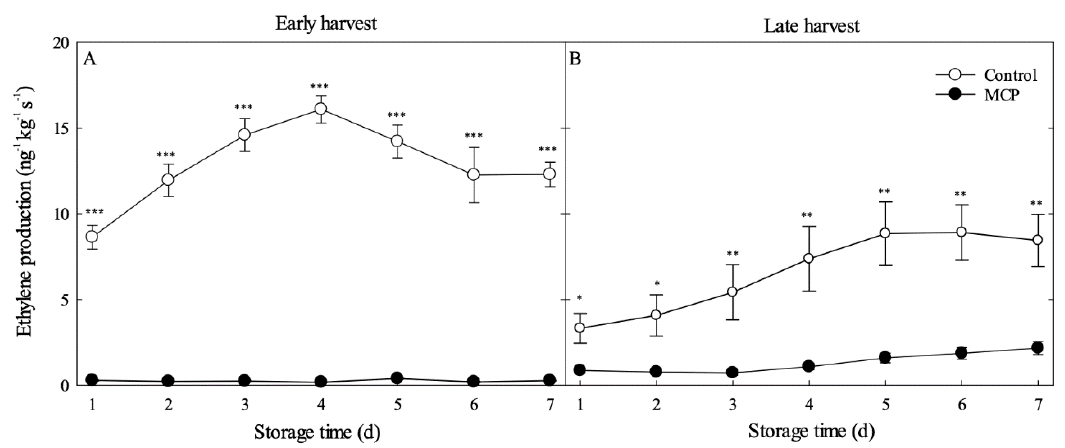
Figure 1. Ethylene production of early ( A ) and late-harvested ‘Empire’ apples ( B ) and stored at 0.5 °C in air storage up to 7 months and evaluated for 7 d at 20 °C. Bars represent error of the means (SEM; n = 5), when larger than the dimension of the symbol. *, **, *** Adjacent to each data point for each storage time indicates significant differences as determined by Duncan’s multiple range test at p ≤ 0.05, 0.01 or 0.001, respectively. MCP-methylcyclopropene.